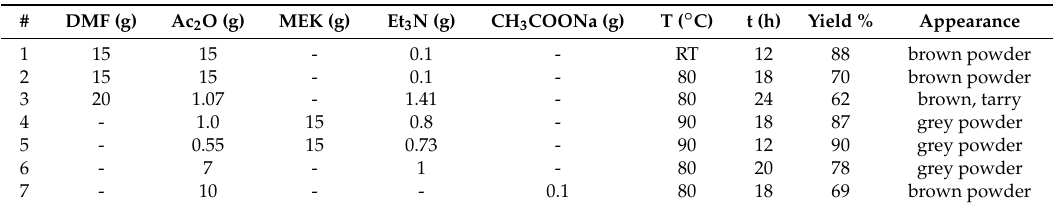
Table 6. Composition of the reaction mixtures, reaction conditions for the chemical imidization of C2, yield, and appearance of the